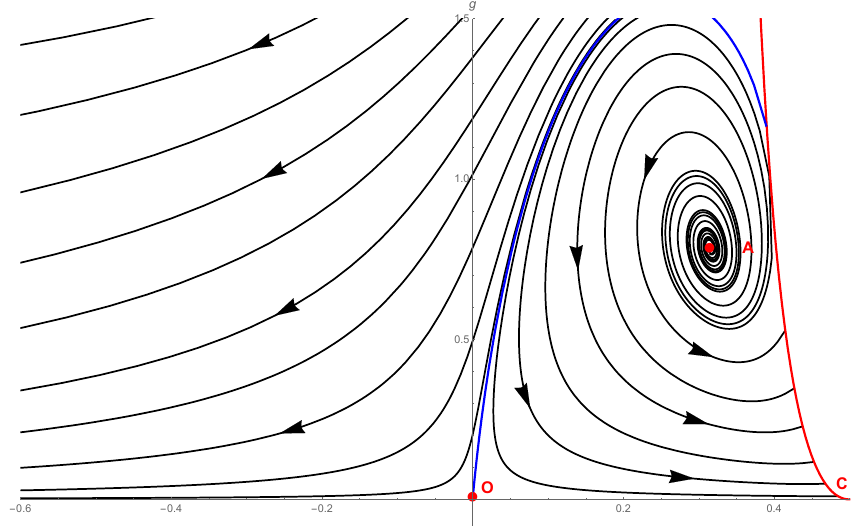
Figure 2 . Phase diagram of the RG (cid:13)ow originating from the beta functions (3.23) in D = 3 + 1 spacetime dimensions. The (cid:13)ow is dominated by the interplay of the NGFP (point \A") controlling the (cid:13)ow for ultra-high energies and the GFP (point \O") governing the low-energy behavior. The (cid:13)ow undergoes a crossover between these two (cid:12)xed points. For some of the RG trajectory this crossover is intersected by the singular locus (4.5) (red line). The arrows indicate the direction of the RG (cid:13)ow pointing from high to low